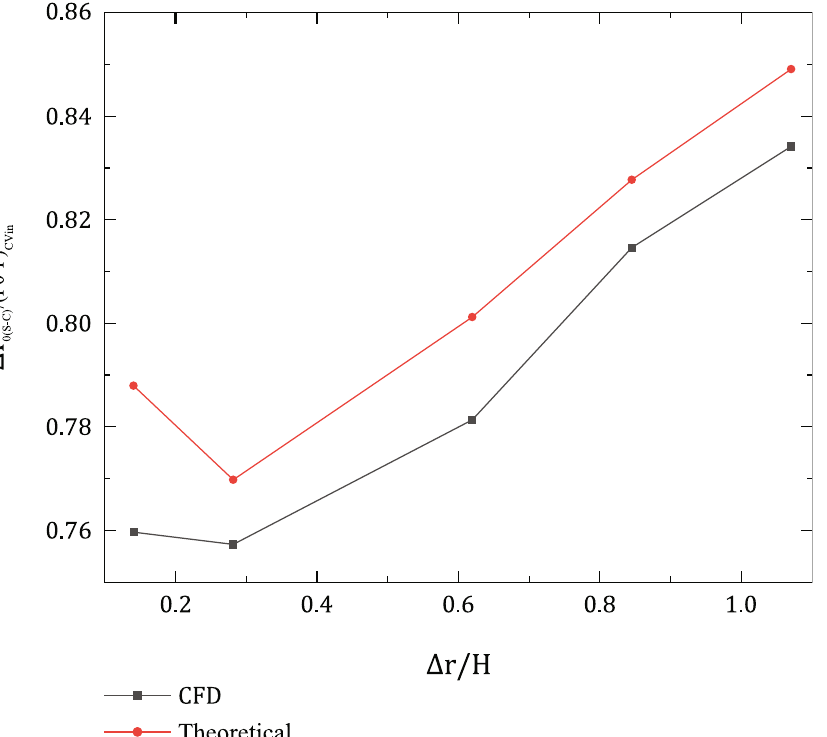
Figure 19: Comparison of results of theoretical model and CFD for SPL coe ffi cient in plenum chamber with di ff ering radial height of plenum chamber.